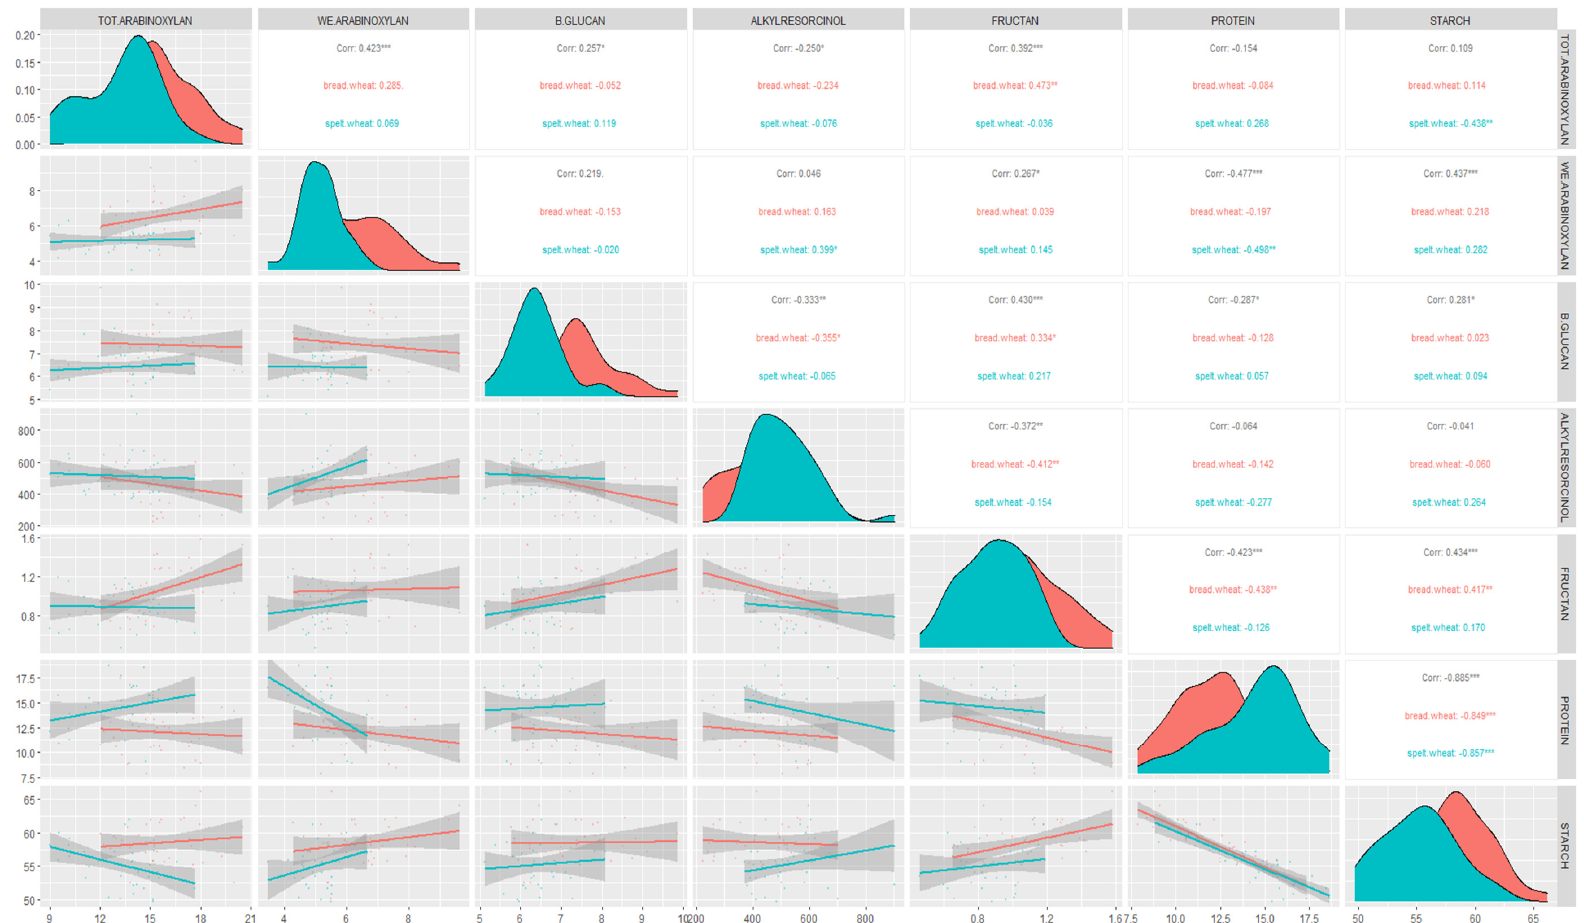
Figure 3. Correlations between the bioactive compound, protein and starch content for bread and spelt wheat. Above the diagonal: the Pearson’s correlation coefficients for bread (red) and spelt (blue) wheat and combined (gray); diagonal: the distributions of each trait for bread (red) and spelt (blue) wheat; below the diagonal: scatter plots with linear regression lines for bread (red) and spelt (blue) and their confidence intervals (gray areas). Correlation coefficients significant for p < 0.001 are marked with ***, those significant for p < 0.01 with ** and p < 0.05 with *. The correlation coefficients that are not marked are not significant.